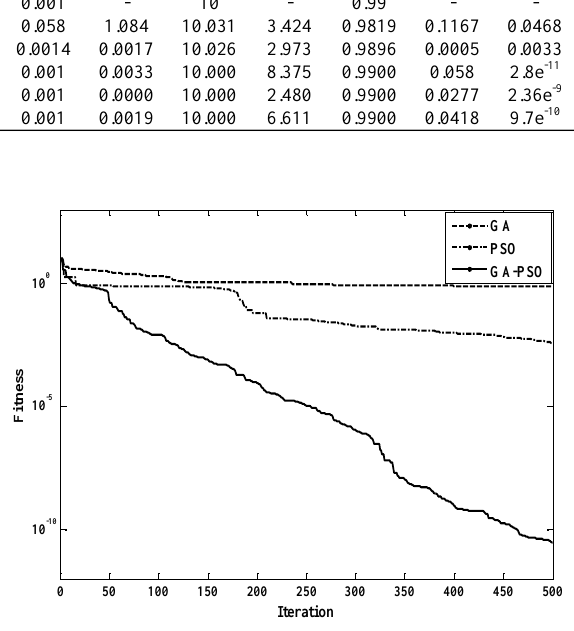
Figure 1. Objective function values J for GA, PSO, and GA-PSO methods.